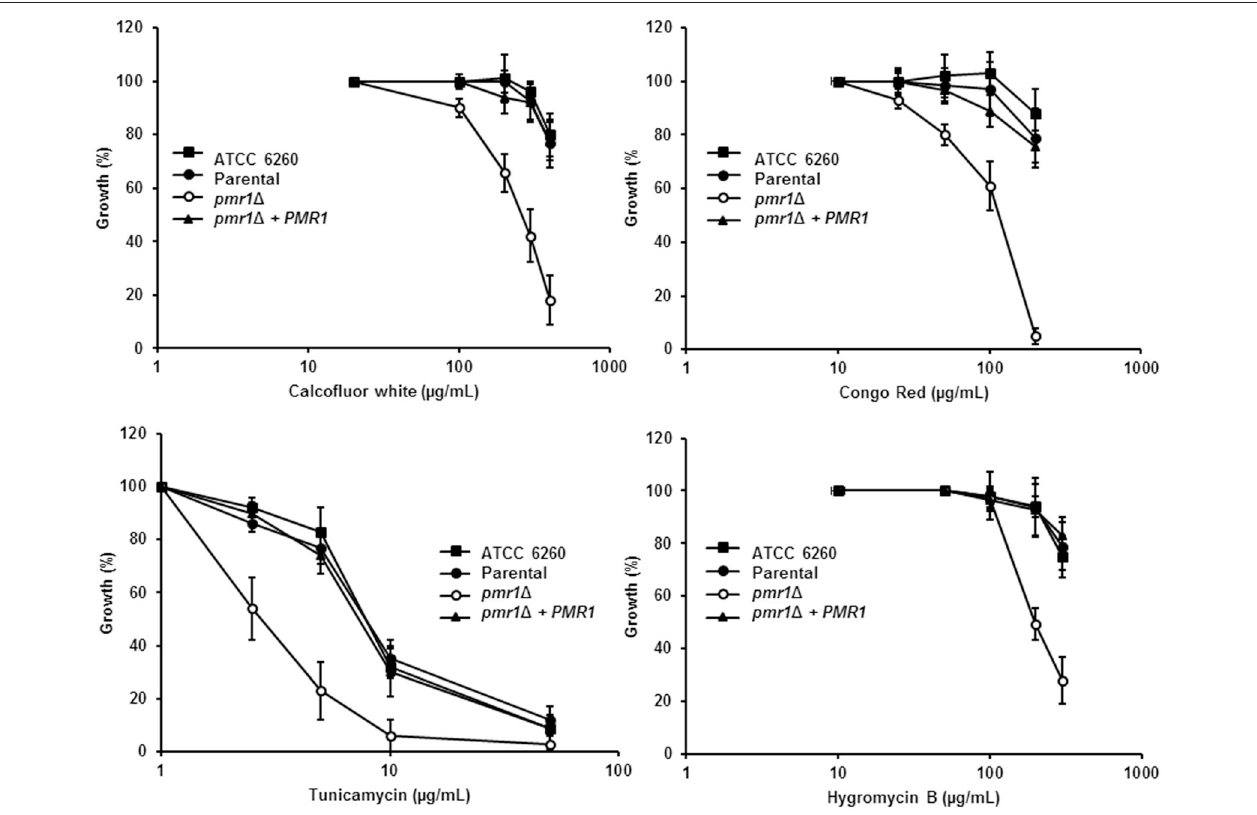
FIGURE 5 | C. guilliermondii pmr1 1 null mutant shows increased susceptibility to cell wall perturbing agents. The C. guilliermondii strains ATCC 6260, KU141 (Parental), HMY134 ( pmr1 1 ), and HMY138 ( pmr1 1 + PMR1 ) were incubated with different concentrations of either Calcofluor White, Congo Red, Tunicamycin, or Hygromycin B, and growth was determined after incubation for 24h at 30 ◦ C. Growth data were normalized as percentage of those generated with the same strain without treatment. For data normalization, growth results are shown as percentage of those obtained with the same strain growing in the absence of any perturbing agent. Data are means ± SD of three independent experiments performed in duplicates. For all the agents tested, the null mutant sensitivity was significantly different to that of the control strains ( P < 0.01 when compared by two-way